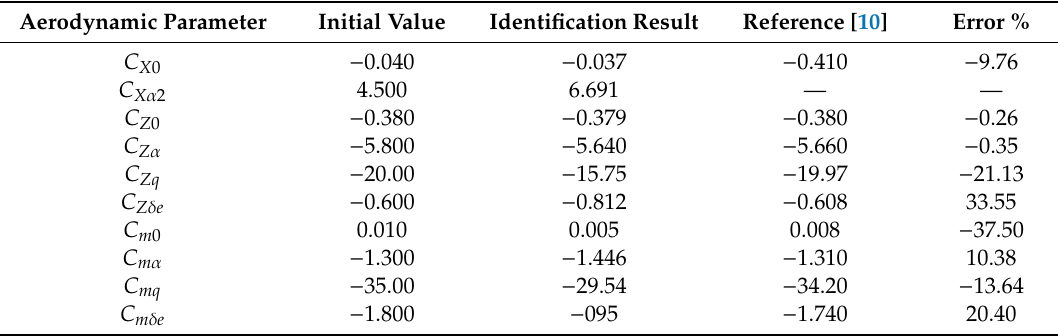
Figure 4. Output responses of clean aircraft. Table 4. Identification results of the clean